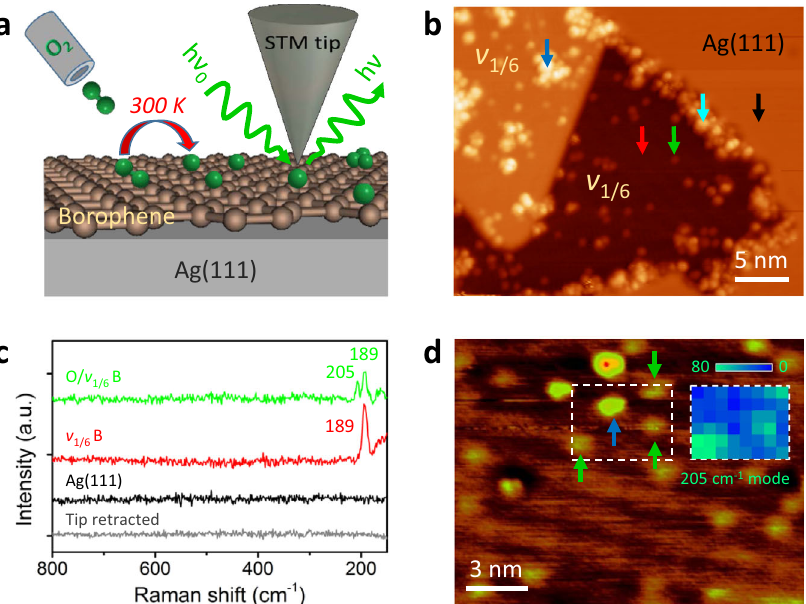
Fig. 3 Oxidation of v 1/6 borophene with molecular oxygen. a Schematic diagram of the experimental design. b STM image of a v 1/6 borophene island across a Ag(111) step edge after exposure to 3600 L of molecular oxygen. Arrows mark the tip positions for the TERS measurements presented in c and Supplementary Fig. 7. c TERS spectra acquired at the sites marked with green, red, and black arrows in b . d STM image of an oxidized borophene surface. Green arrows indicate three oxygen adatoms and a blue arrow marks a high cluster. 2D TERS map of the region marked by the white box is superimposed. TERS measurement parameters: c 0.1 V, 2 nA, 5 s; d 0.1 V, 3 nA, 2 s per pixel with a step length of 6.0 Å. Scanning conditions: b 0.5 V, 1.0 nA; d 1.3 V, 100 pA.